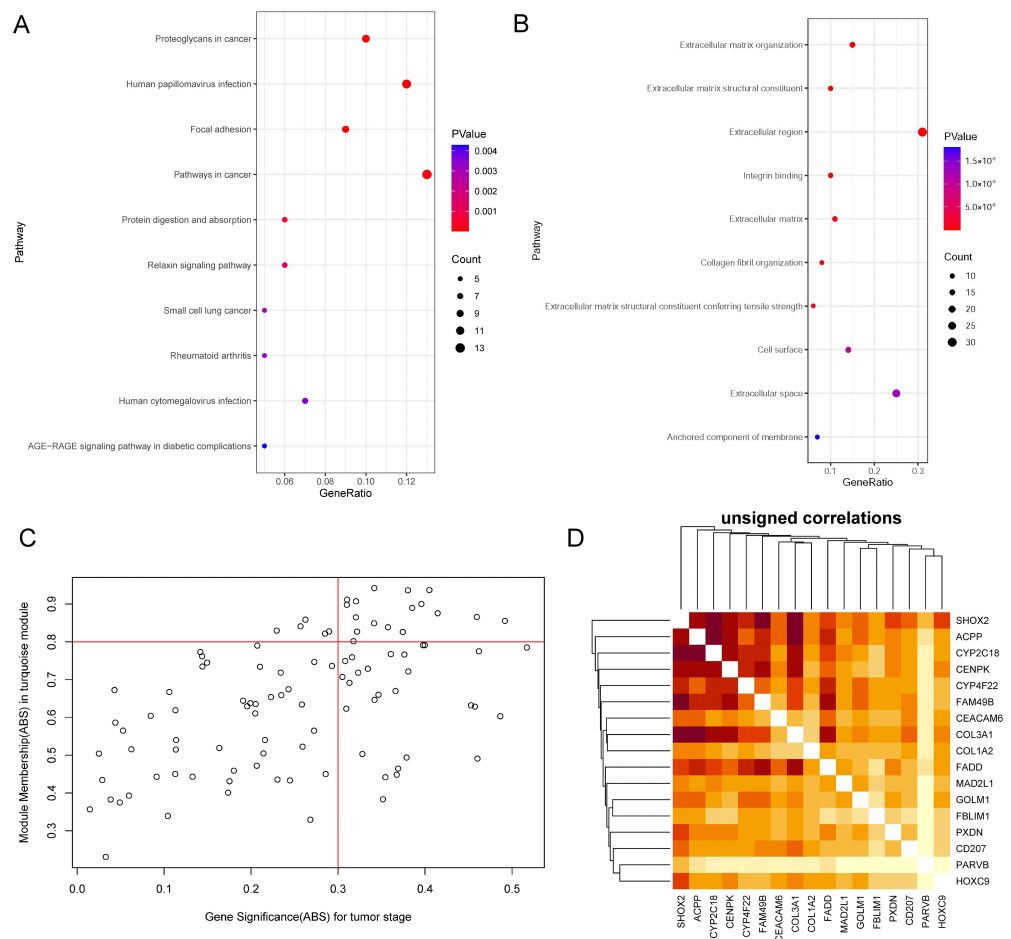
Figure 2. Functional annotation of key modules and selection of hub genes. GO categories and KEGG pathways annotation of the DEGs in HNSCC. Gene count is represented by dot size. p -value is represented by color. ( A ) GO categories. ( B ) KEGG pathways. ( C ) The scatter plot of module eigengenes in the turquoise module. The two red lines indicate the standards of the selection of the hub genes (module membership (ABS) > 0.8 and gene significance (ABS) > 0.3). Each hollow circle represents one gene in the turquoise module. ( D ) The heatmap of 17 selected hub genes is based on their topological overlap matrix (TOM). Color intensity varies positively with the correlation of hub